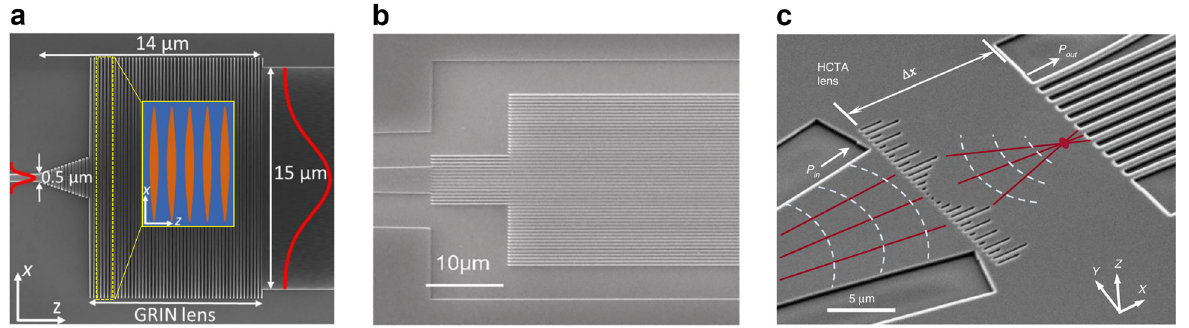
Figure 11: On-chip integrated lenses implemented with SWG structures. (a)GRIN-lensspotsizeconverter[32].(b)4-fsystemcomprisingtwoGRINlensesusingasubwavelengthstackingofsiliconstrips[78].(c)On-chip